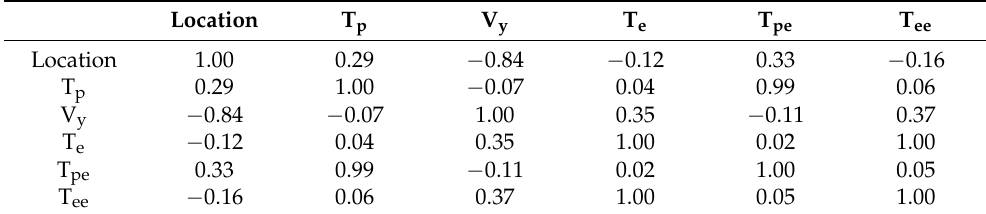
Table 3. Correlation